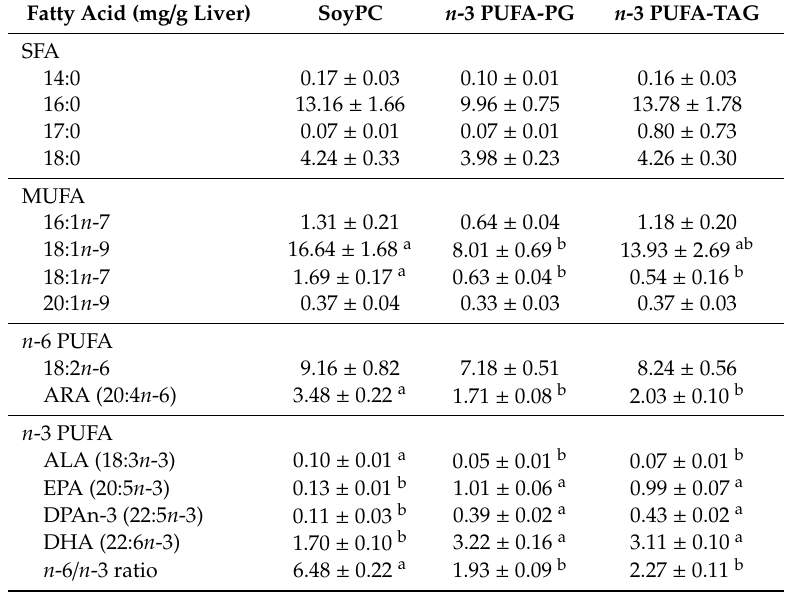
Table 6. Fatty acid composition of total lipid in the liver of KK- A y mice fed experimental diets. Fatty Acid (mg / g Liver) SoyPC n -3 PUFA-PG n -3